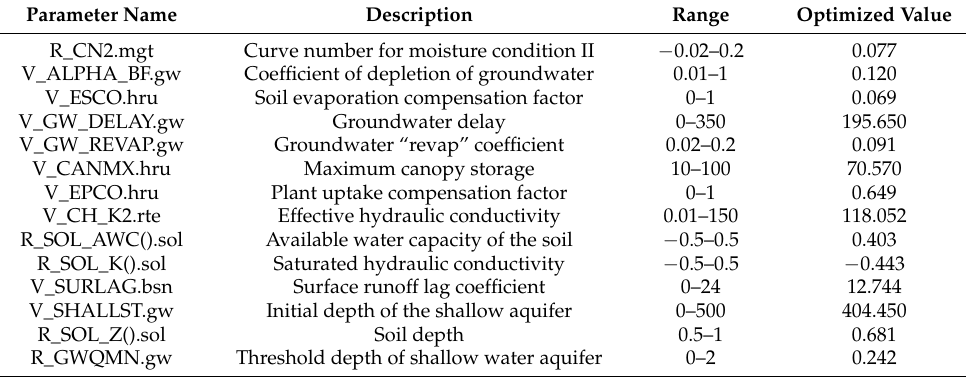
Table 1. Sensitive model calibration parameters and optimized values for LULC-2000